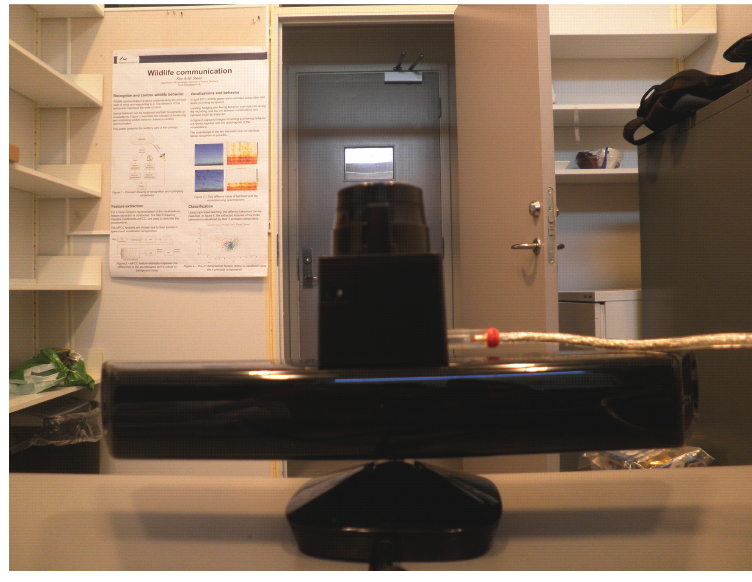
and the laser range finder, which is placed TM . TM